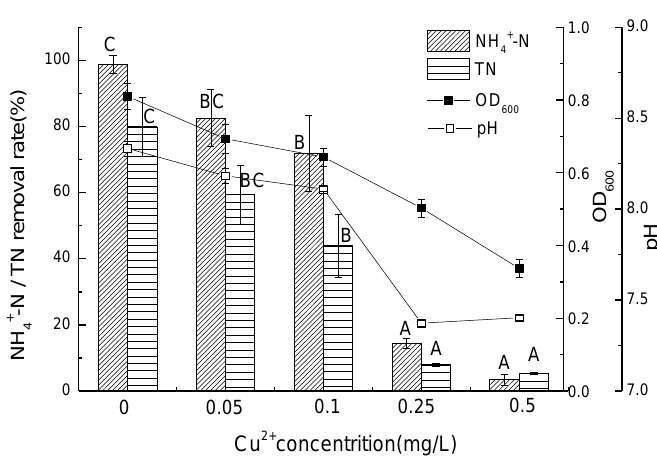
Figure 3. Effects of Cu 2+ on ammonium nitrogen removal performance of strain D51.